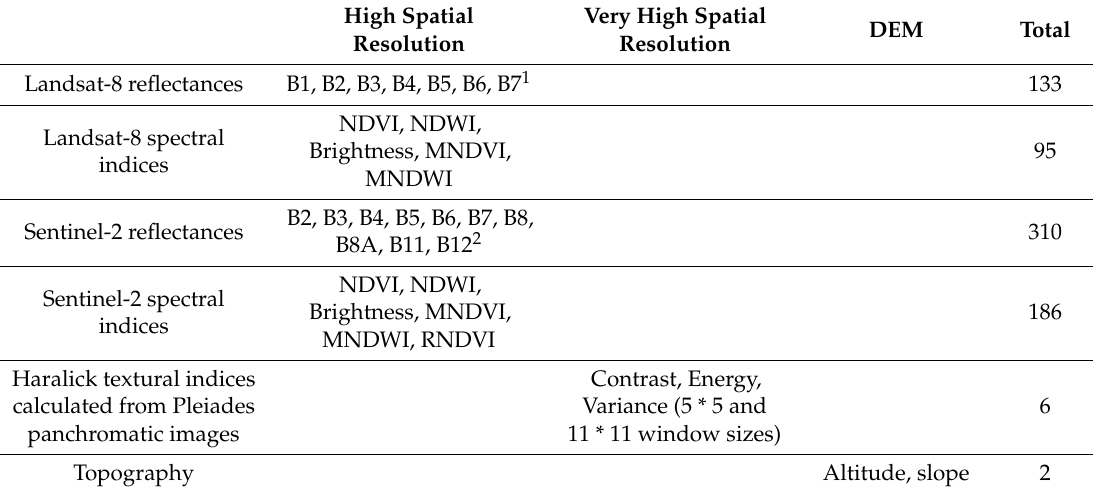
Table 2. List of the 732 features used in the classification process. The type of feature is given in rows and the source in columns. NDVI, normalized di ff erence vegetation index; NDWI, normalized di ff erence water index; MNDVI, modified normalized di ff erence vegetation index; MNDWI,